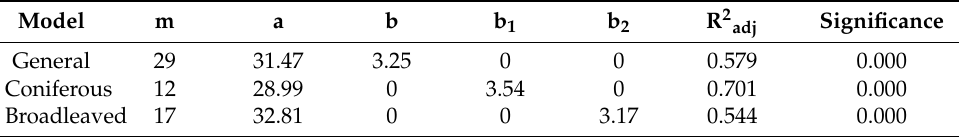
Table 6. Model regression analysis